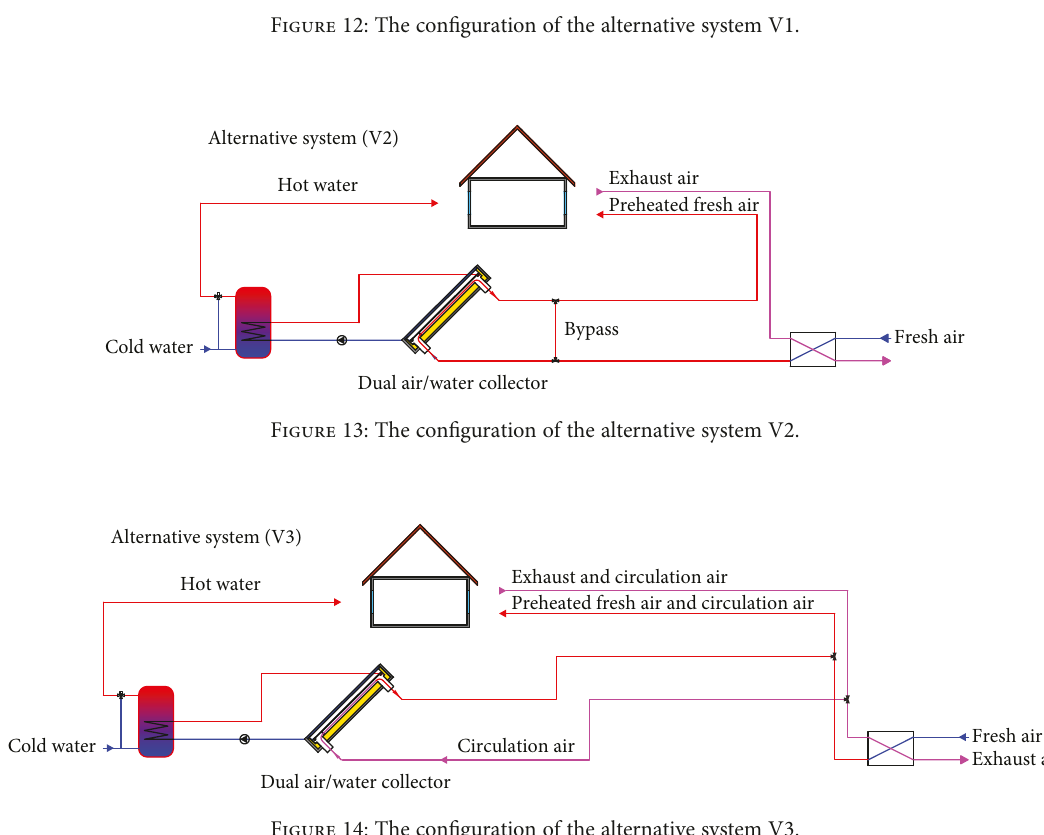
Figure 14: The con fi guration of the alternative system